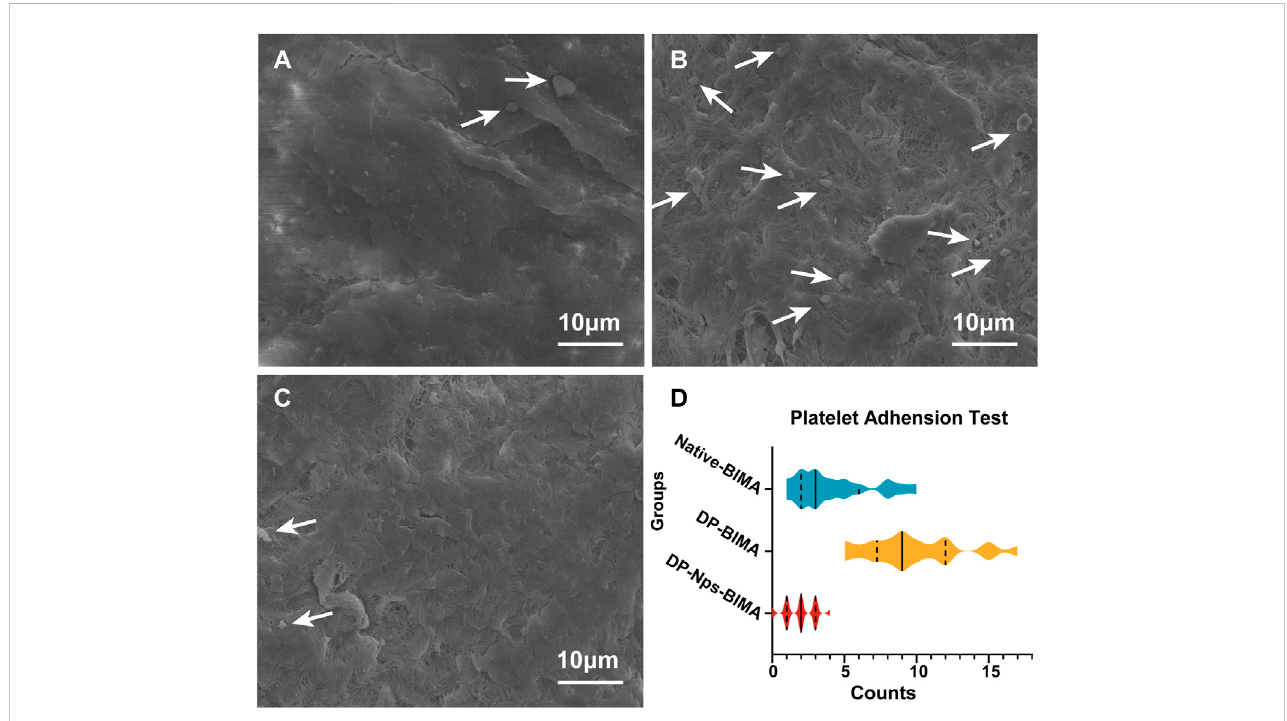
FIGURE 6 Theresultsofplateletsadhesionassayfordifferentgroups. (A) isthenativeBIMA, (B) istheDP-BIMA,and (C) istheDP-Nps-VEGFBIMA.Thewhitearrows indicatetheadheredplateletsontheluminalsurfacesofeachgroups. (D) isthestatisticalgraphwhichindicatesthequartilesofthethreegroups,thesolidline indicates the median and the dotted lines indicate the fi rst and third quartile ( n =